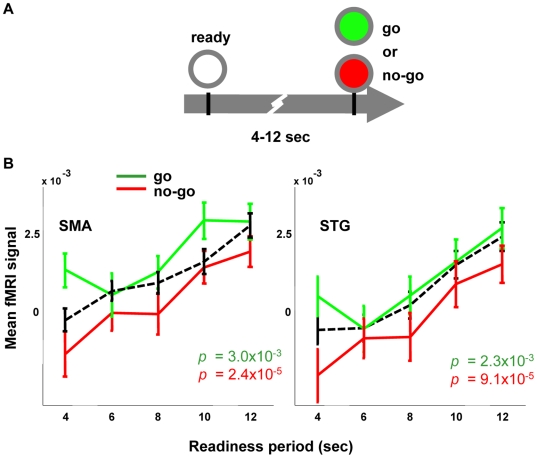
Longer readiness period causes higher fMRI signal in the absence of motor output.(A) The gray circle may be filled with red or green with equal probability. Participants are instructed not to press the button when they see red. (B) The post-trial fMRI signal amplitude is correlated with the readiness period in both the go (green) and no-go (red) trials (p-values of the correlation, inset). Note that baseline activity is slightly lower in the no-go condition, suggesting that motor output provides a constant signal offset that is independent of the waiting-time-dependent encoding described in this paper. For comparison, the dashed line shows the signal from the original experiment (Figure 1D). Error bars SEM.